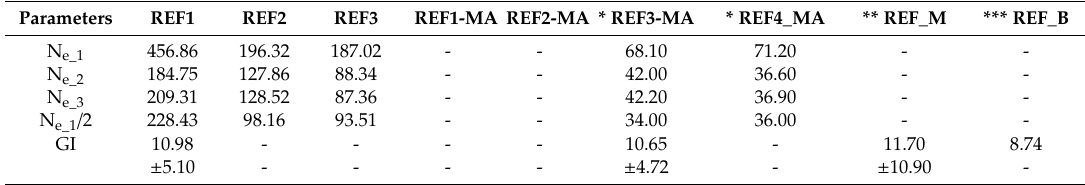
Table 4. Populations structure parameters of SAA, Maremmano, Murgese,